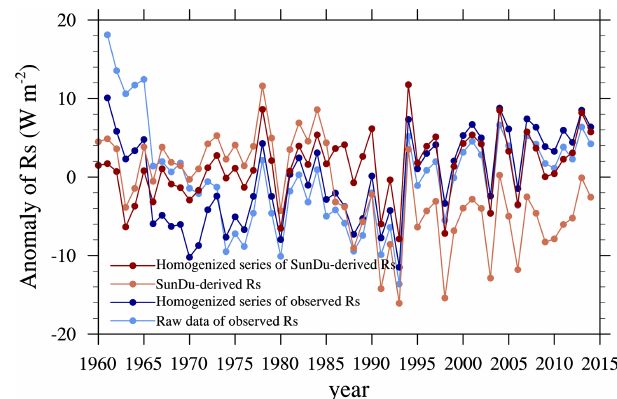
Figure 8. Time series of annual anomalies of surface incident solar radiation ( R s ) based on direct R s observations (light-blue line) and their homogenized series (dark-blue line) and sunshine-duration- derived (SunDu-derived) R s (light-red line) and their homogenized series (dark-red line). All of the lines were calculated based on ob- servations at 41 sites. Details on how these 41 sites were selected are given in Sect. 3.1. The R s variations are nearly the same as those shown in Fig. 7, which were calculated based on all available ob- servations.